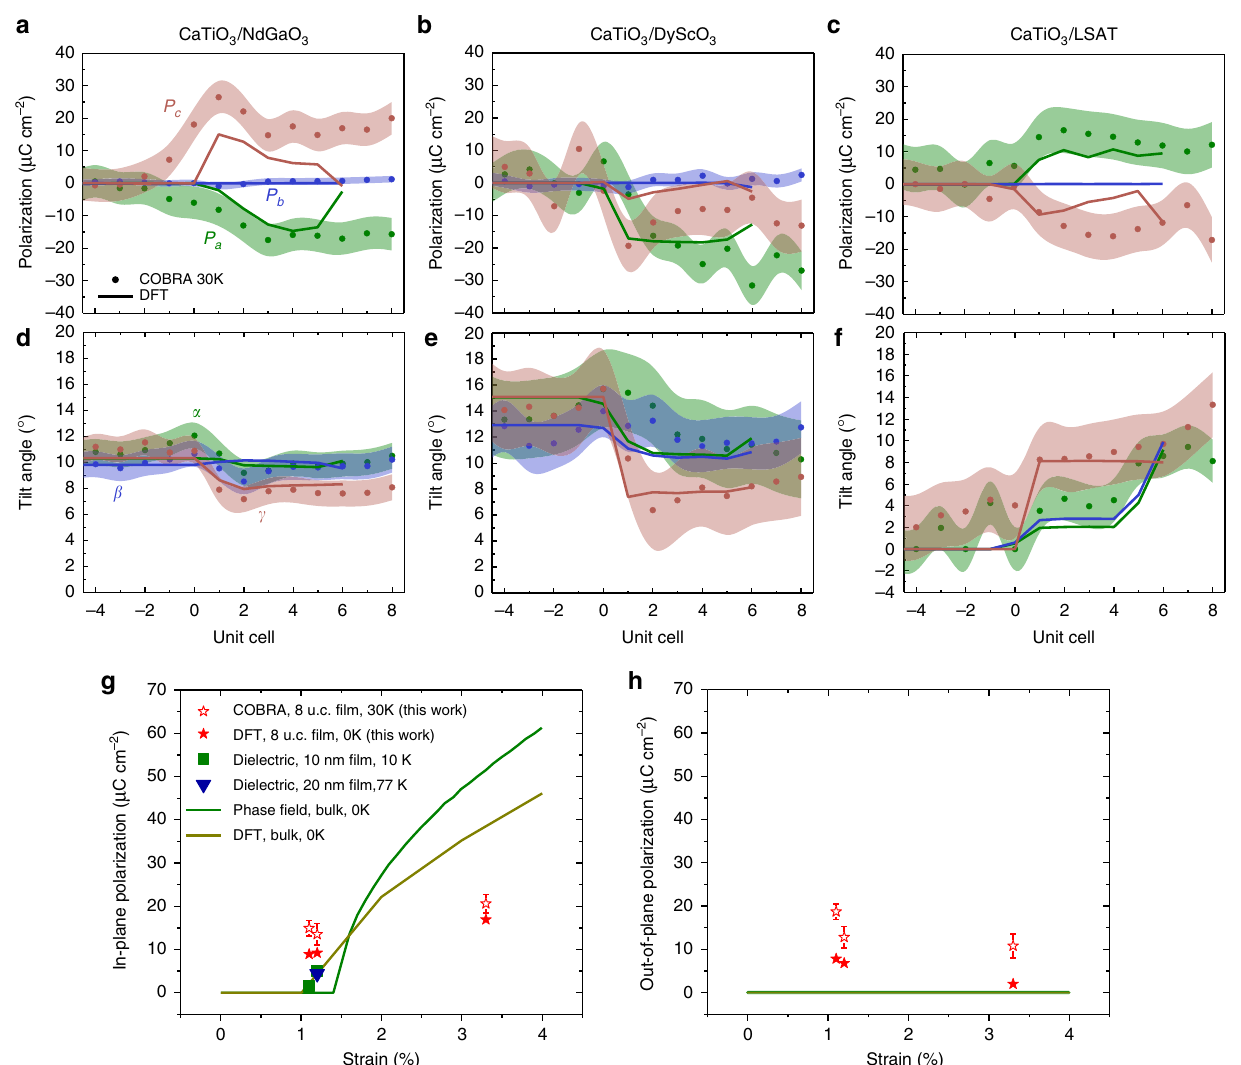
Fig. 3 Tilt angles and polarizations in ultrathin CaTiO 3 fi lms. a - c Polarization components, P a (green), P b (blue), and P c (red), as well as d - f quanti fi ed tilt angles, α (green), β (blue), and γ (red), extracted from coherent Bragg rods analysis (COBRA) (dots) and density functional theory (DFT) (solid lines) are compared for the fi lms on NdGaO 3 , DyScO 3 , and LSAT. The experimental errors are estimated by comparing COBRA results for substrates to their bulk reference values and are indicated by the shaded area surrounding the COBRA data dots. g The polarization state of ultrathin CaTiO 3 are compared to literature reports on thick samples (>10 nm). Theoretical works by phase fi eld simulation (green line 47 ) and DFT (yellow line 46 ) were performed on bulk CaTiO 3 at 0 K. Experimental works on epitaxial thin fi lm were measured by low temperature dielectric measurements. Green squares show measurements on 10 nm CaTiO 3 at 10 K 49 . Blue triangle shows measurement on 20 nm CaTiO 3 at 77 K 48 . The in-plane polarizations obtained by COBRA method at 30 K for 8 u.c. fi lms and DFT for 6 u.c. fi lms are respectively plotted using red open and closed stars. h Phase fi eld (green line) and DFT (yellow line) show no out-of-plane polarization for strained bulk CaTiO 3 . COBRA (red open star) and DFT (red closed star) reveal a clear non-zero out-of-plane polarization in ultrathin CaTiO 3 fi